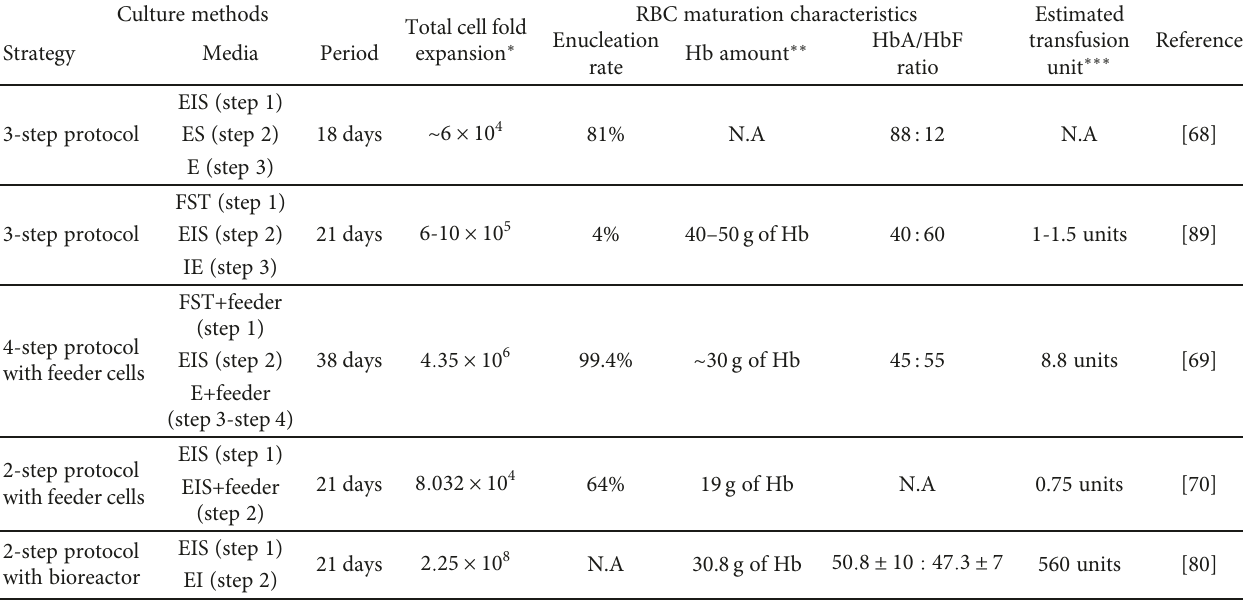
Table 2: Current representative RBC-producing strategies using circulating